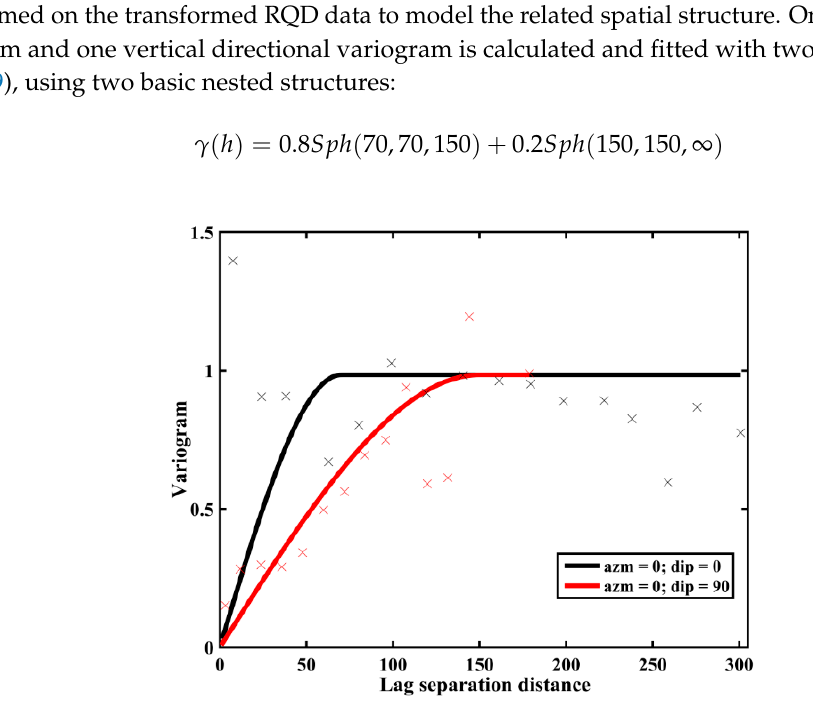
Figure 9. Direct variograms of Gaussian variables (cross points: experimental variogram and solid lines: theoretical variogram modeled to the experimental).